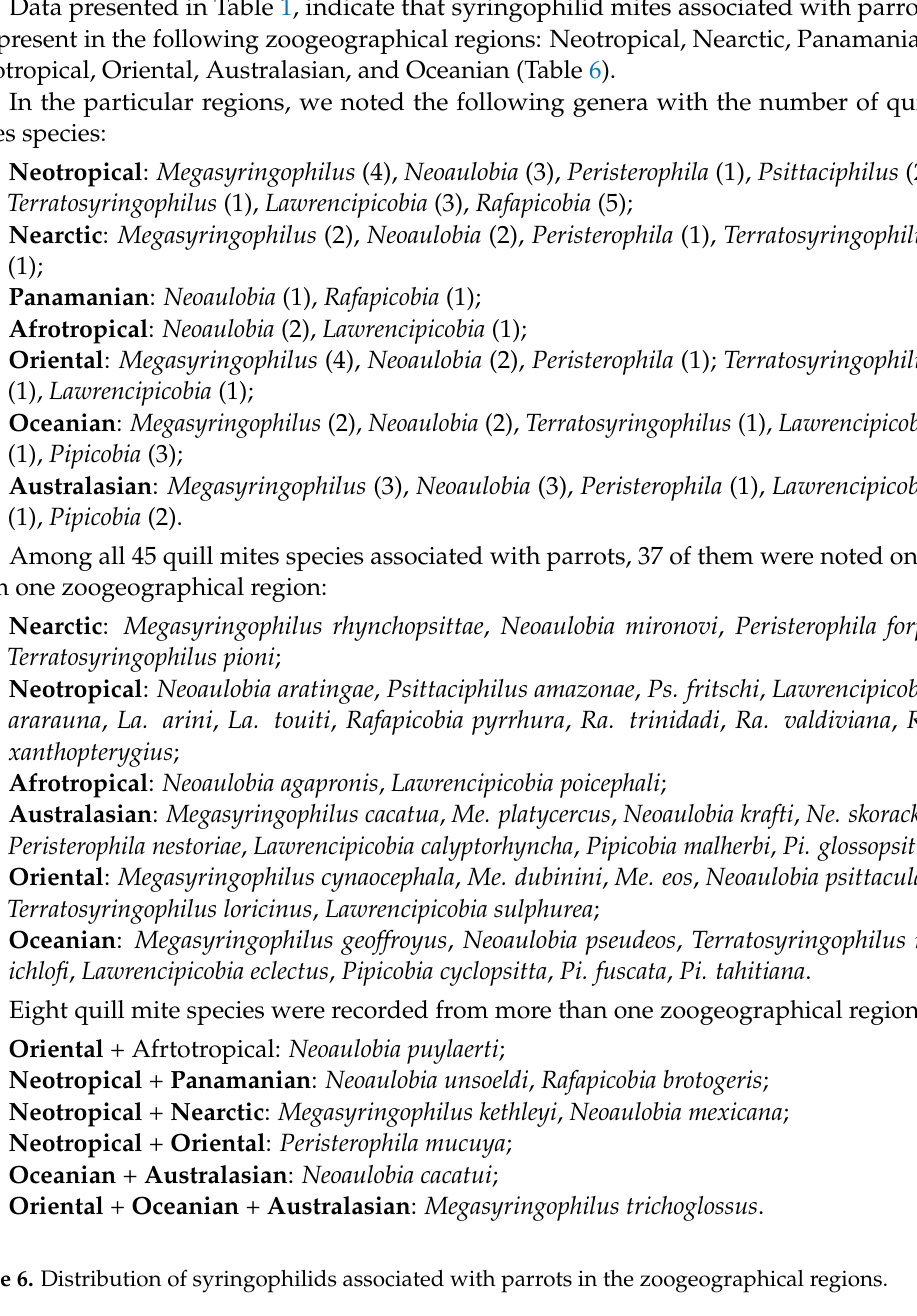
Table 6. Distribution of syringophilids associated with parrots in the zoogeographical regions. Zoogeographical Region Quill Mites Species Neot. Near. Pana. Afro. Orie. Ocean.